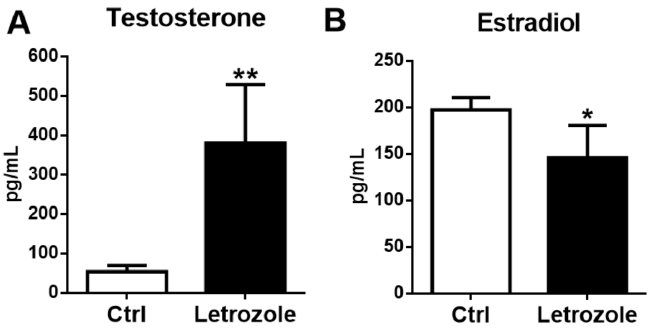
Figure 2. Plasma testosterone levels in the letrozole-treated mice were significantly higher than in the control mice ( A ), and estradiol levels were significantly lower in the letrozole-treated mice ( B ). Results are expressed as the mean ± SD. * p < 0.05; ** p < 0.01, compared with the control mice.